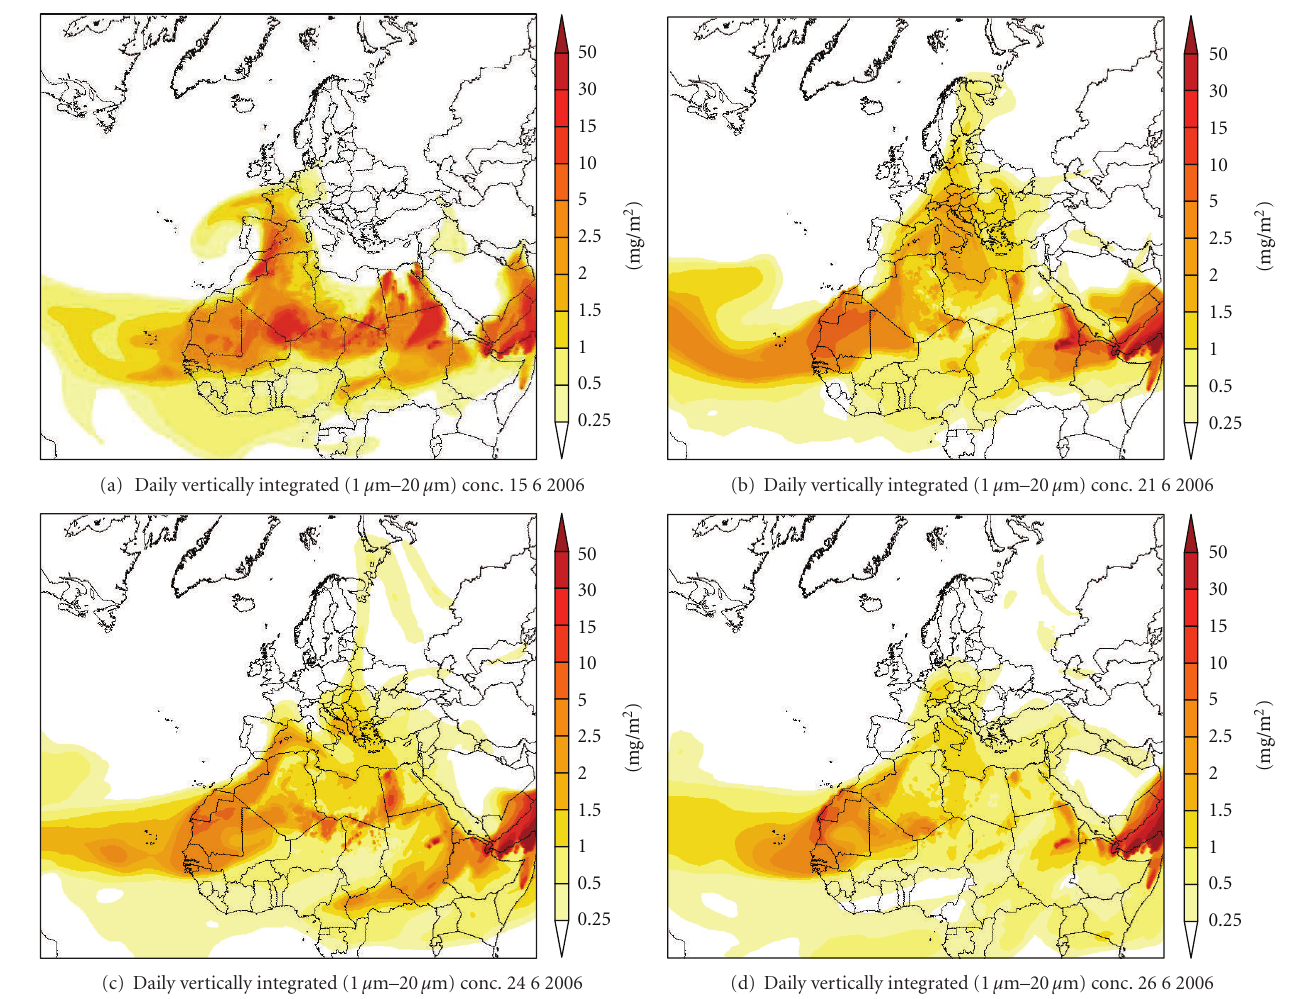
Figure 6: Daily vertically integrated dust concentration for 15th of June (a), 21st of June (b), 24th of June (c), and 26th of June 2006 (d). increase of the Ti/Fe and Al/Ca ratios are indicated as highly representative fingerprints of African dust transport